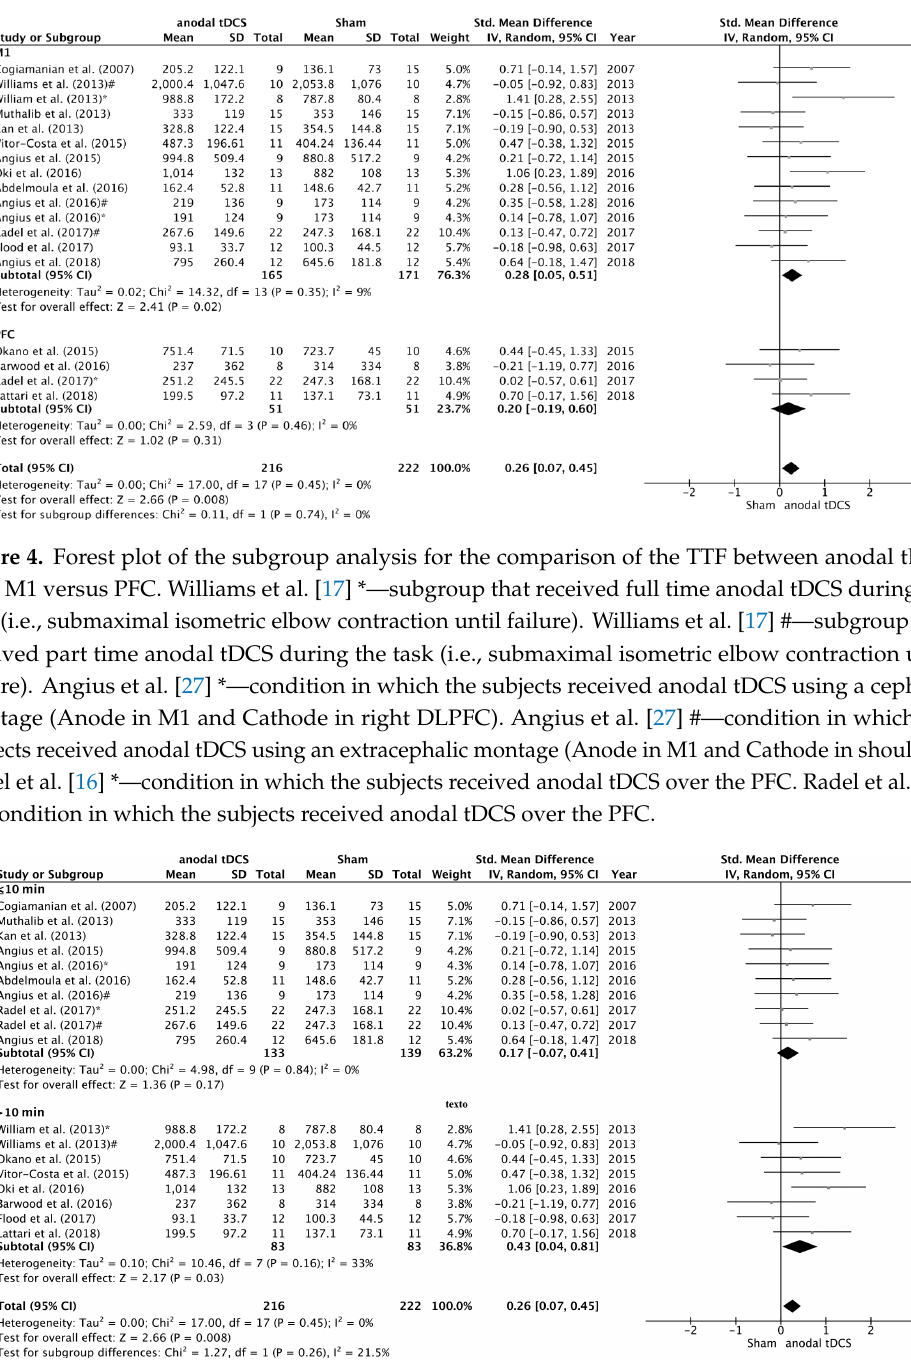
Figure 5. Forest plot of the subgroup analysis for the comparison of the TTF between anodal tDCS applied ≤ 10 min. versus > 10 min. Williams et al. [17] *—subgroup that received full time anodal tDCS during the task (i.e., submaximal isometric elbow contraction until failure). Williams et al. [17] #—subgroup that received part time anodal tDCS during the task (i.e., submaximal isometric elbow contraction until failure). Angius et al. [27] *—condition in which the subjects received anodal tDCS using a cephalic montage (Anode in M1 and Cathode in right DLPFC). Angius et al. [27] #—condition in which the subjects received anodal tDCS using an extracephalic montage (Anode in M1 and Cathode in shoulder). Radel et al. [16] *—condition in which the subjects received anodal tDCS over the PFC. Radel et al. [16] #—condition in which the subjects received anodal tDCS over the